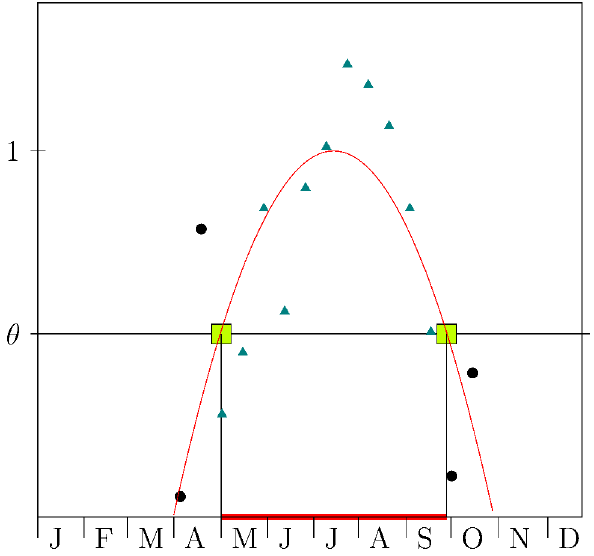
Figure 2. Detection of seasonal abundance time-windows. The time series of captured mice has been interpolated by a quadratic polynomial curve. By normalising the obtained parabola to unity and setting a threshold h ( ~ 0 : 5 in the example), we identify mice captured in high abundance season, those above the threshold h (triangles), and mice captured in low abundance period, those below the threshold (circles).